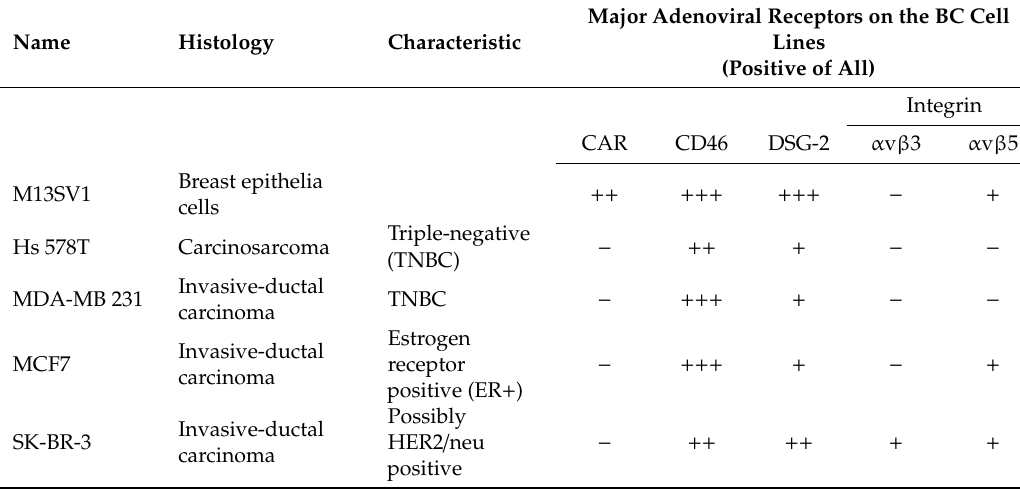
Table 1. Breast cancer (BC)-related cell lines used in this